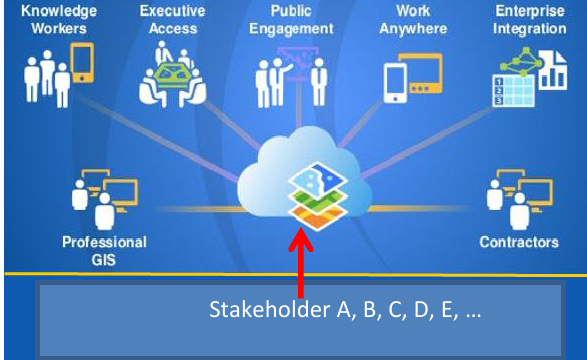
Figure 12: Illustration of an integrated GIS system architecture. Some characteristics of integrated GIS system are:  Support more than one GIS online system for